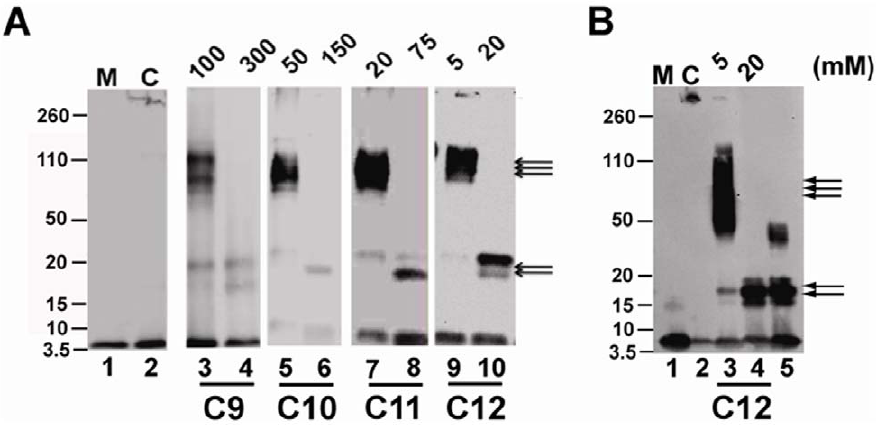
Figure 5. Western blots of A b 42 samples after 48 h of incubation in the presence of fatty acids near and above the CMC, respectively. A) SDS-PAGE was run on a 12% bis-tris acrylamide gels in Laemmli buffer. Double arrow indicates 4–5 mers while the triple arrow indicates 12–18 mers. The monomeric A b 42 and control (in the absence of fatty acids) are represented by M and C respectively. B) Western blots of A b 42 samples incubated in the presence of C12 NEFA near and above the CMC run on 4–12% NuPage gels for comparison. M and C represent the monomeric, and control A b 42 samples (lanes 1 and 2). Lanes 3 and 4 are C12 incubations with 5 and 20 mM respectively while lane 5 is the incubation of A b 42 in 2 mM SDS as a positive control.